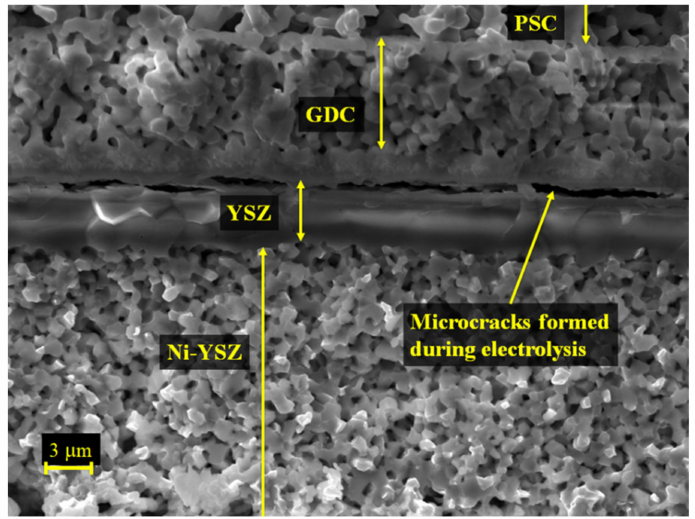
Figure 14. SEM picture of a cross section of the electrolysis cell depicting a delaminating oxygen